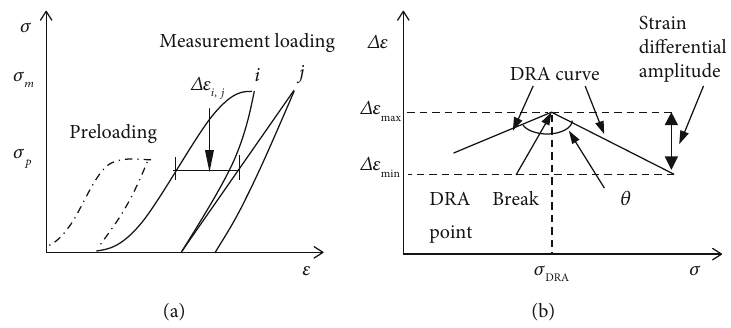
Figure 3: De fi nition of deformation rate analysis. (a) De fi nition of strain di ff erential Δε